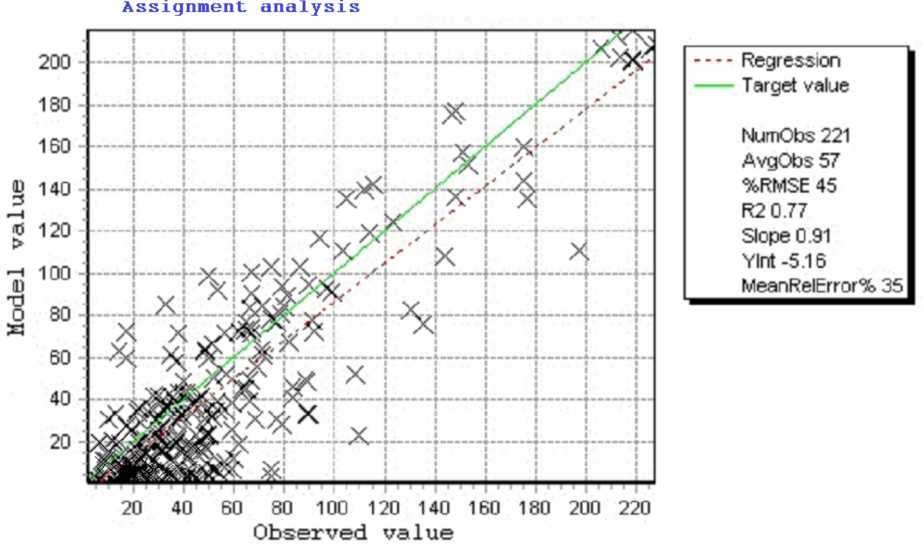
Figure 10. Goodness of fit of the bicycle traffic assignment to the Gdynia transport